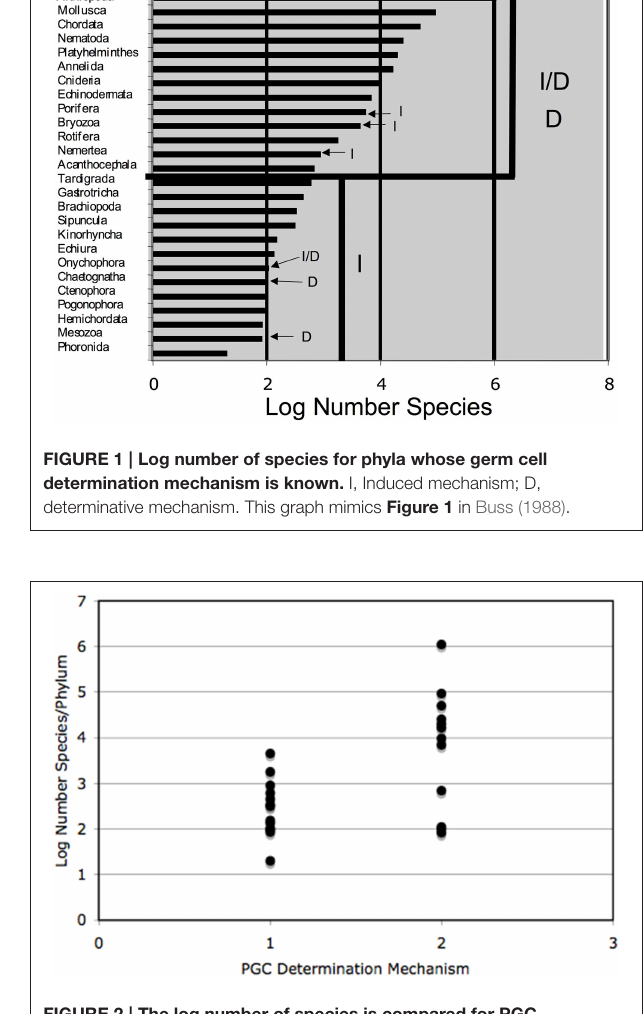
FIGURE 2 | The log number of species is compared for PGC determination mechanism only. Number of species per group came from Table 1 and citations therein. Each dot represents the log number of species/phylum. These data were found to be statistically significantly different (see text for details). 1, induced/induced mechanism; 2, determinative